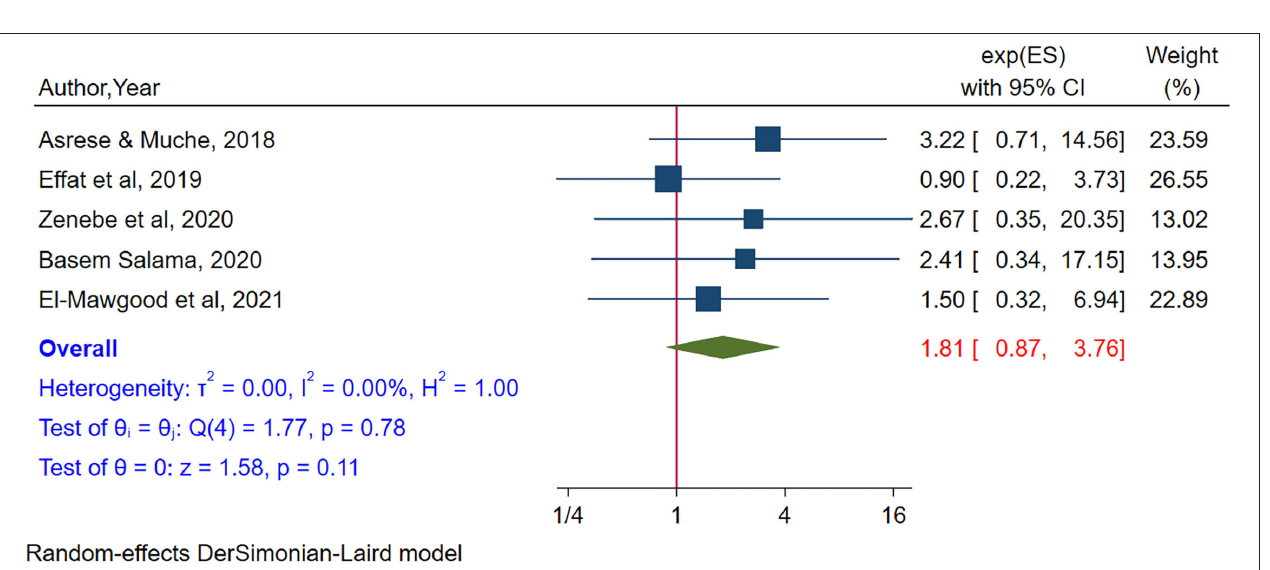
heterogeneity was observed between studies (I 2 = 0.00%, P - value = 0.82) ( Figure 9 ). Egger’s test showed no small study effect ( P -value = 0.94). In sensitivity analysis, no single study was found to influence the estimates ( Supplementary Figure 8